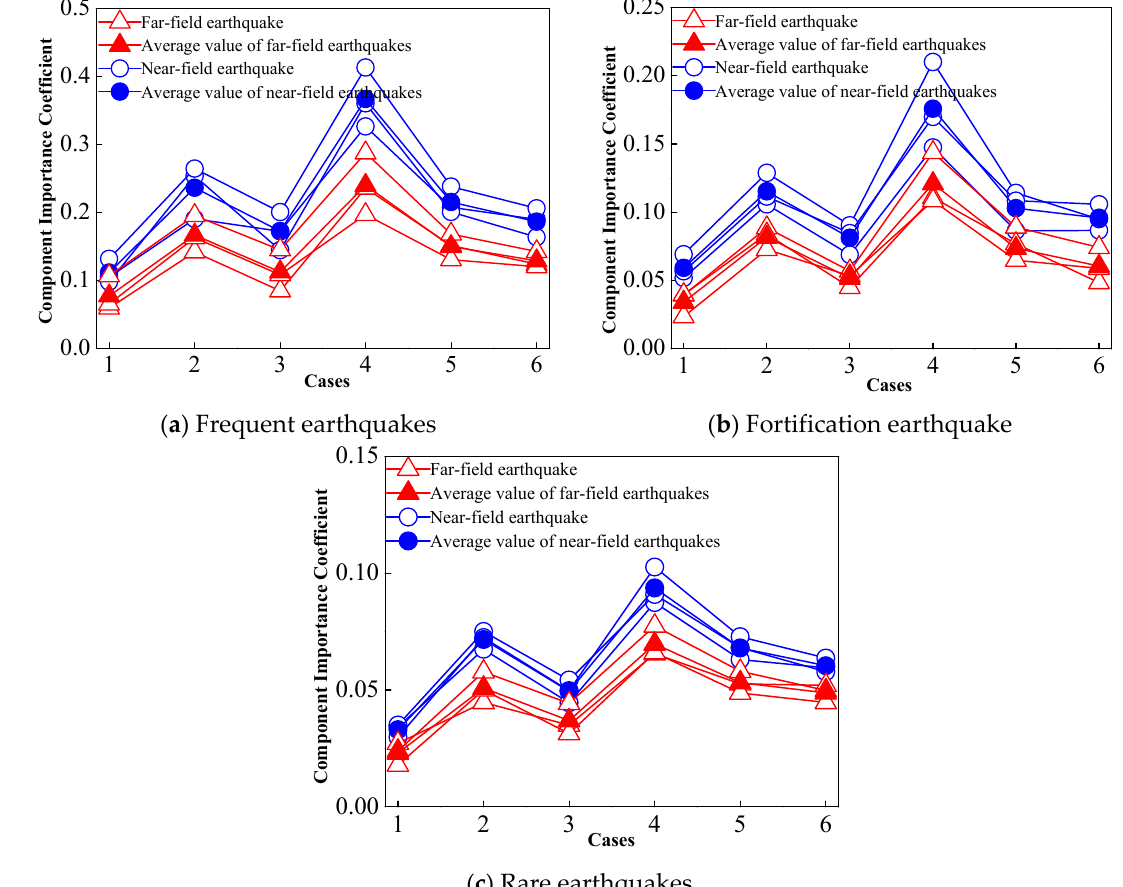
Figure 6. Component importance coefficient curves of model A.